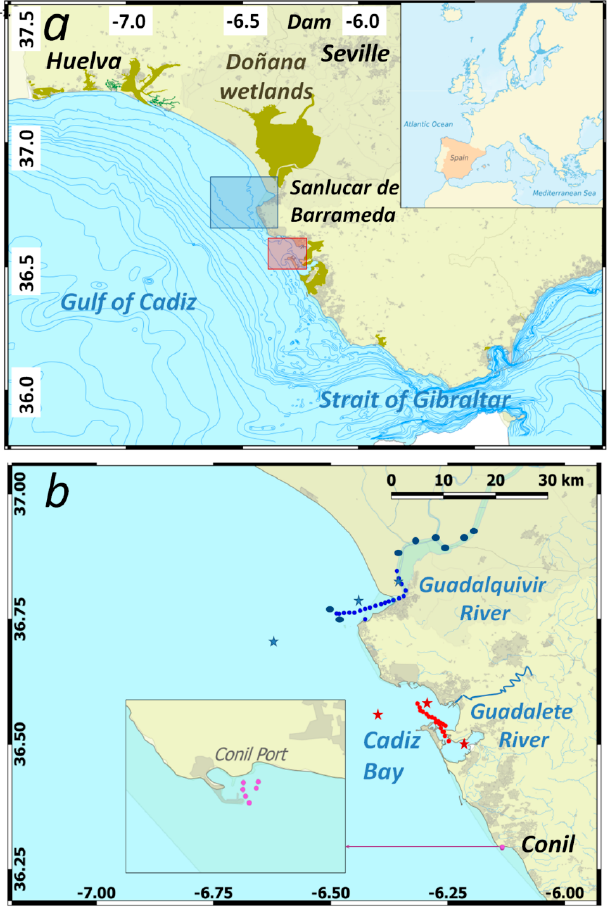
Figure 1. ( a ) Location of the study area (SW Iberian Peninsula) showing the Strait of Gibraltar and the Gulf of Cadiz. Blue and red rectangles delimit the ROI (Region of Interest) in the Guadalquivir estuary and Cadiz Bay, respectively; ( b ) In-situ sampling data set corresponding to match-ups in each site is indicated for the Guadalquivir estuary (blue dots, 16 June and 13 December 2016), Cadiz Bay (red dots, 6 June 2016) and Conil port (pink dots, 27 May 2016). Blue (Guadalquivir estuary) and red (Cadiz Bay) stars correspond to the location of the 5 × 5 pixels used for the Atmospheric Correction comparison ranging from offshore estuary at Box 1 (36.696°N, 6.676°W) to estuarine or turbid waters at Box 2 (36.773°N, 6.438°W) and Box 3 (36.811°N, 6.343°W), and from offshore bay at Box 1 (36.571°N, 6.38°W) to turbid waters at Box 2 (36.55°N, 6.253°W) and Box 3 (36.503°N, 6.203°W).